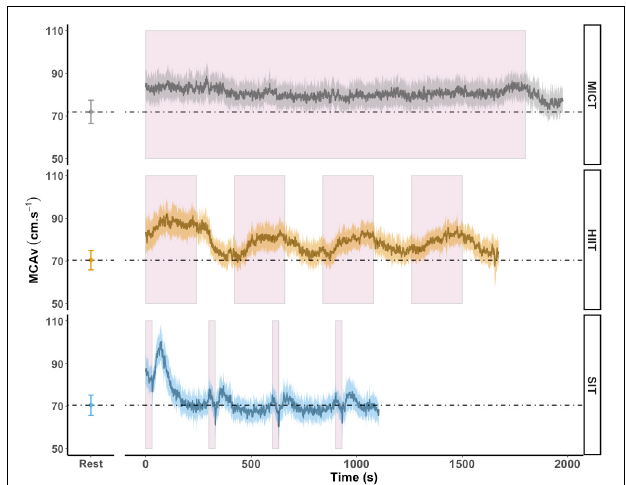
FIGURE 4 | MCAv was determined continuously by transcranial doppler ultrasound (TCD) and exported at 1 Hz frequency from the onset of each protocol after warm-up had been completed. Exercise protocols were: 30 min of moderate intensity (65% VO 2 peak ) steady state exercise (MICT); four 4 min high intensity (85% HR max ) interval bouts (HIIT) separated by 3 min active recovery at 50 W and four 30 s supramaximal (200% W max ) sprint intervals (SIT) separated by 4.5 min active recovery at 50 W, with all protocols followed by 3 min of active recovery at 50 W. Data are presented as average ± 95% confidence intervals ( n = 18), across the duration of each protocol including active recovery periods, with resting values averaged over 30 s of seated rest presented for comparison. These time periods were identical to those used in calculation of area under the curve (AUC). Continuous effort during MICT and the timing of the four interval periods in HIIT and SIT are highlighted in